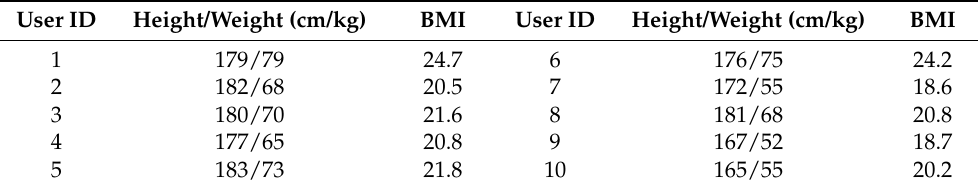
Table 2. Statistics of participants.